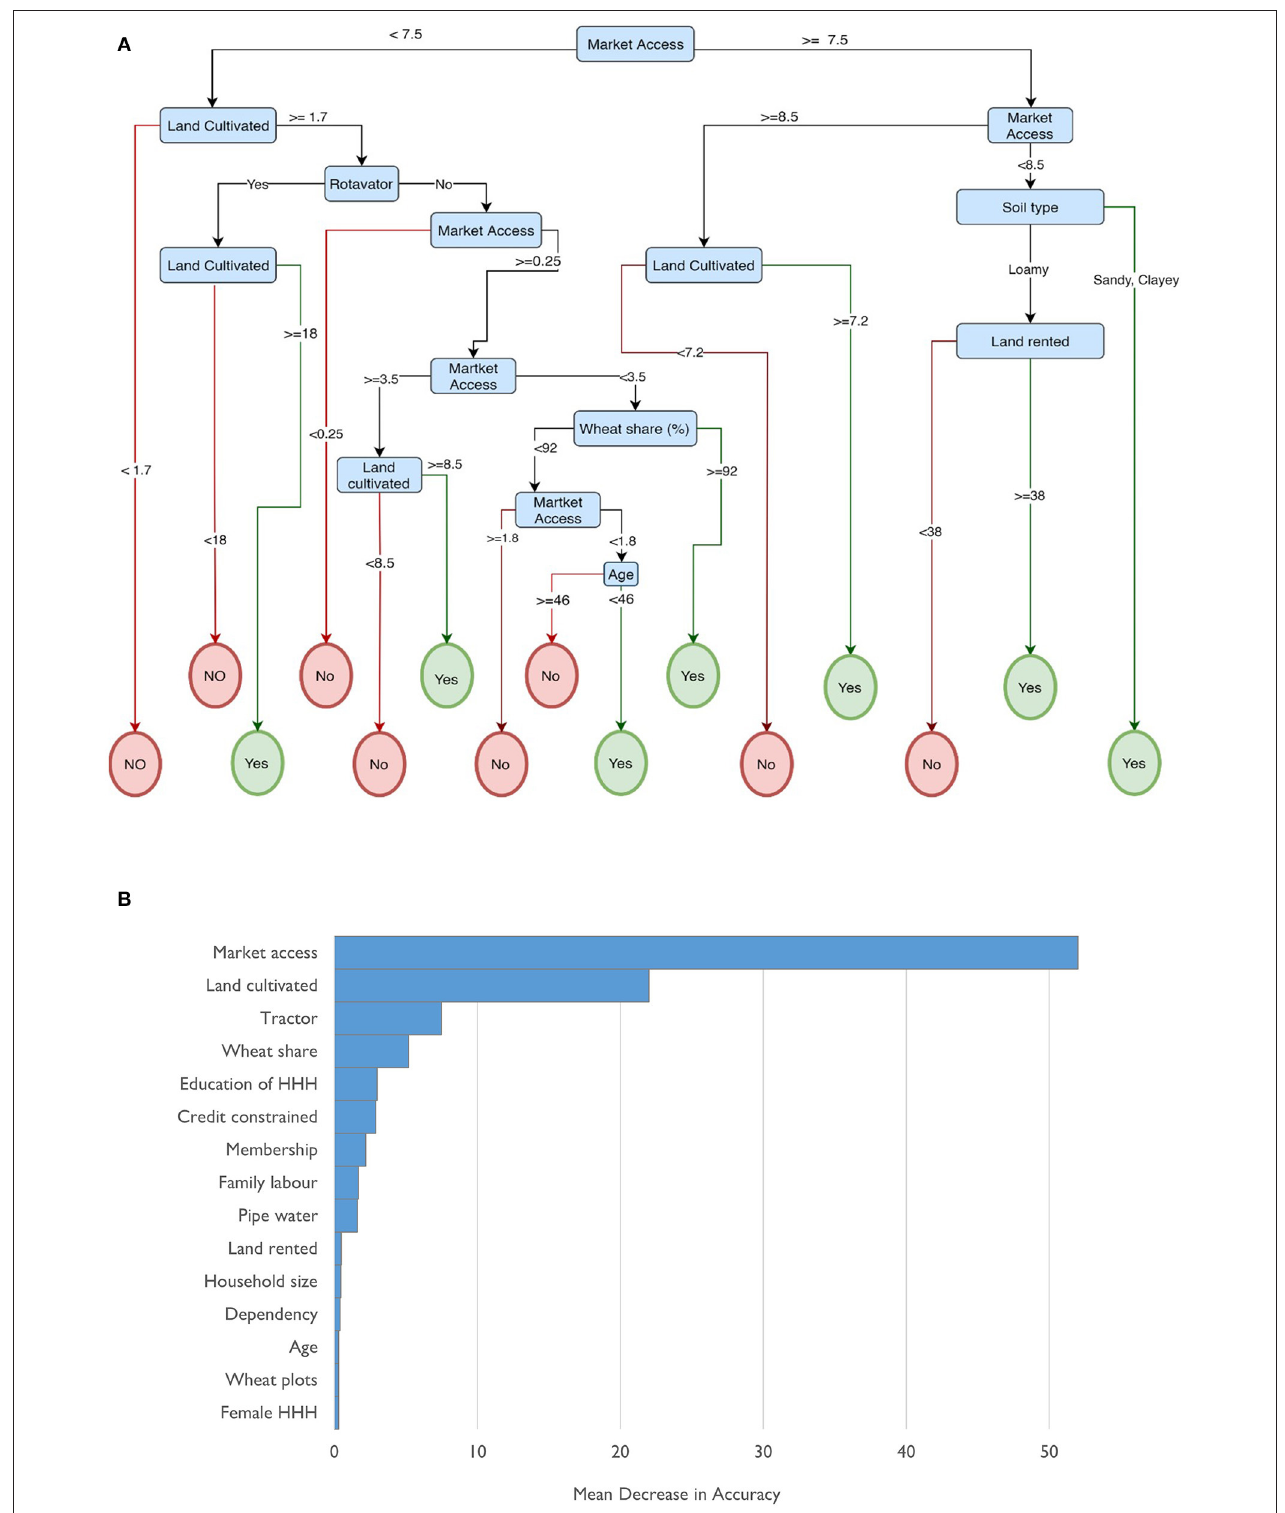
FIGURE 2 | (A) Correlation and Regression Trees (CART) on Farmer Adoption of Zero Tillage in Punjab. The variables are defined, and summary statistics provided in Supplementary Materials S1(a) . (B) Importance of predictor variables in the Random Forest Models on ZT adoption in Punjab. The variables are defined in Supplementary Materials S1(a)